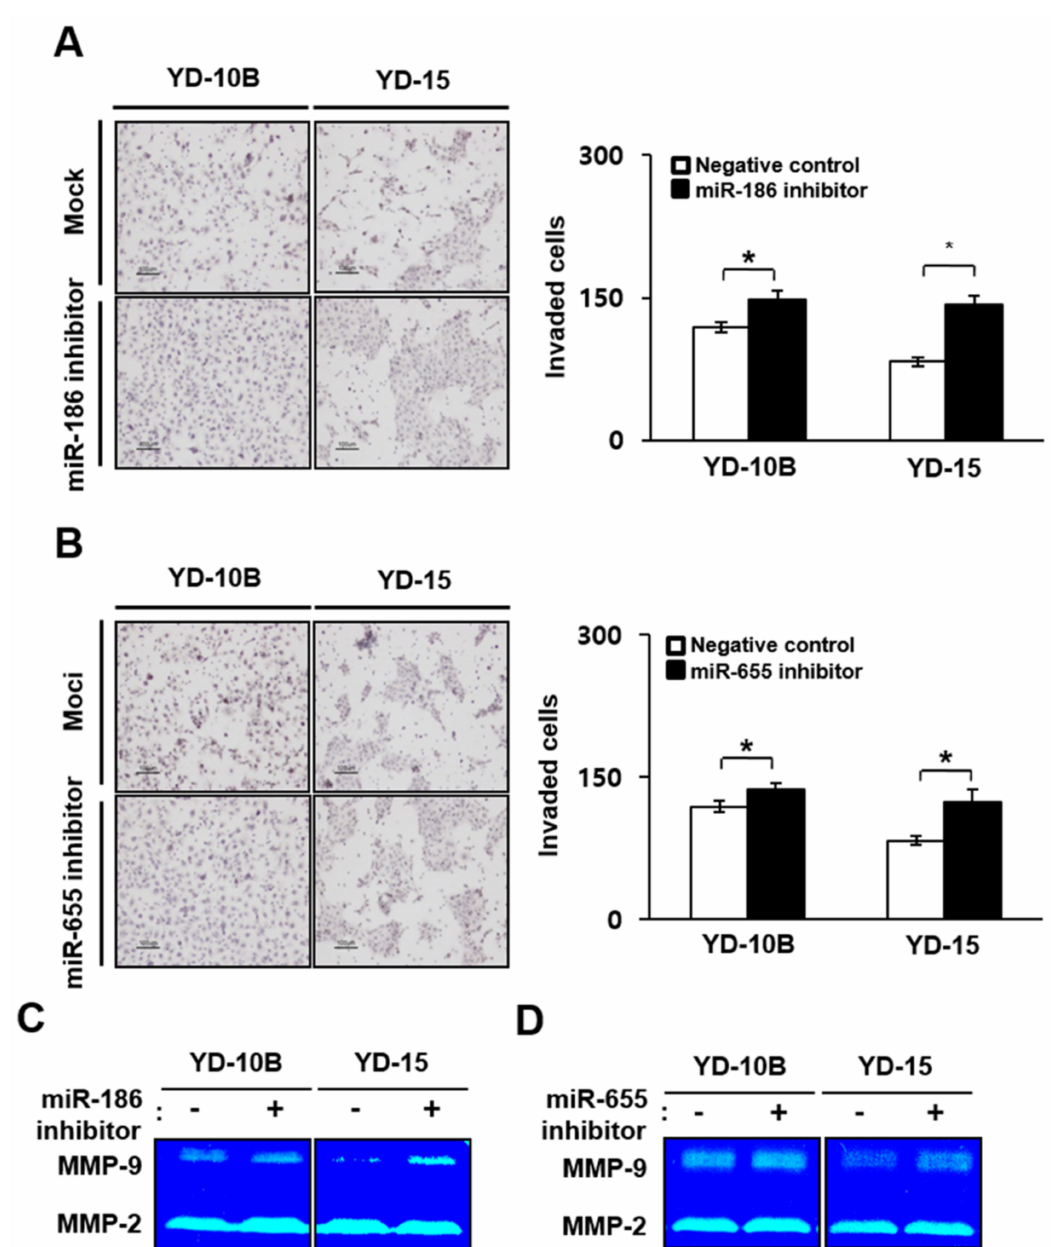
Figure 7. Effect of downregulated miR-186 and -655 on invasion abilities of oral SCC cell lines. Image (left) and numbers (right) of invaded YD-10B and YD-15 cells treated with ( A ) miR-186 and ( B ) miR-655 inhibitory sequences. Magnification, × 100; scale bar = 100 µ m. The values are means ± standard errors. * indicates significant differences between negative control and inhibitor treatment. All experiments were performed in triplicate. Activity of MMP-9 and -2 analyzed by zymography in YD-10B and YD-15 cells treated with ( C ) miR-186 and ( D ) miR-655 mimic